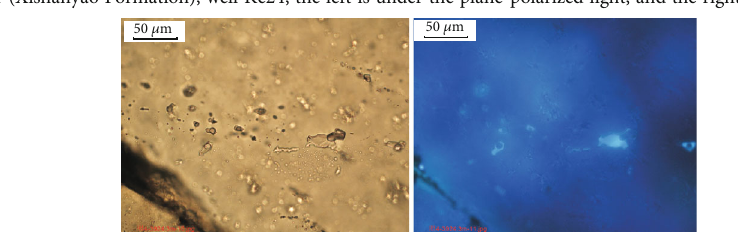
(e) Transparent colorless-gray gas-liquid hydrocarbon inclusion (condensate) with blue-green fl uorescence, well Zhao4; the left is under the plane-polarized light, and the right is under the UV-light Figure 4: